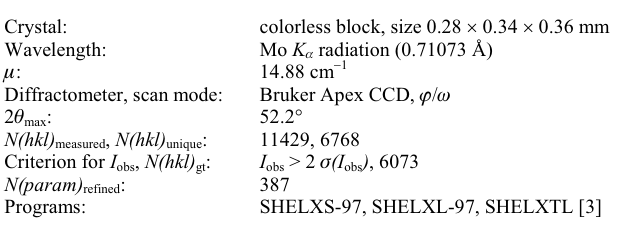
Table 1. Data collection and handling.